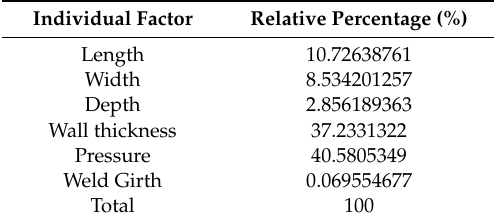
Table 5. Relative Contribution of individual factors.